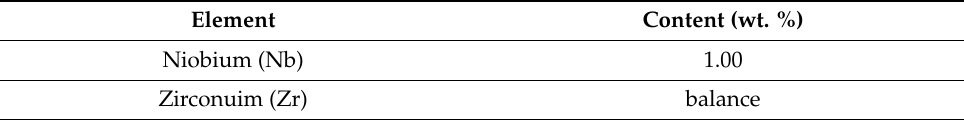
Table 1. Average chemical composition of E110